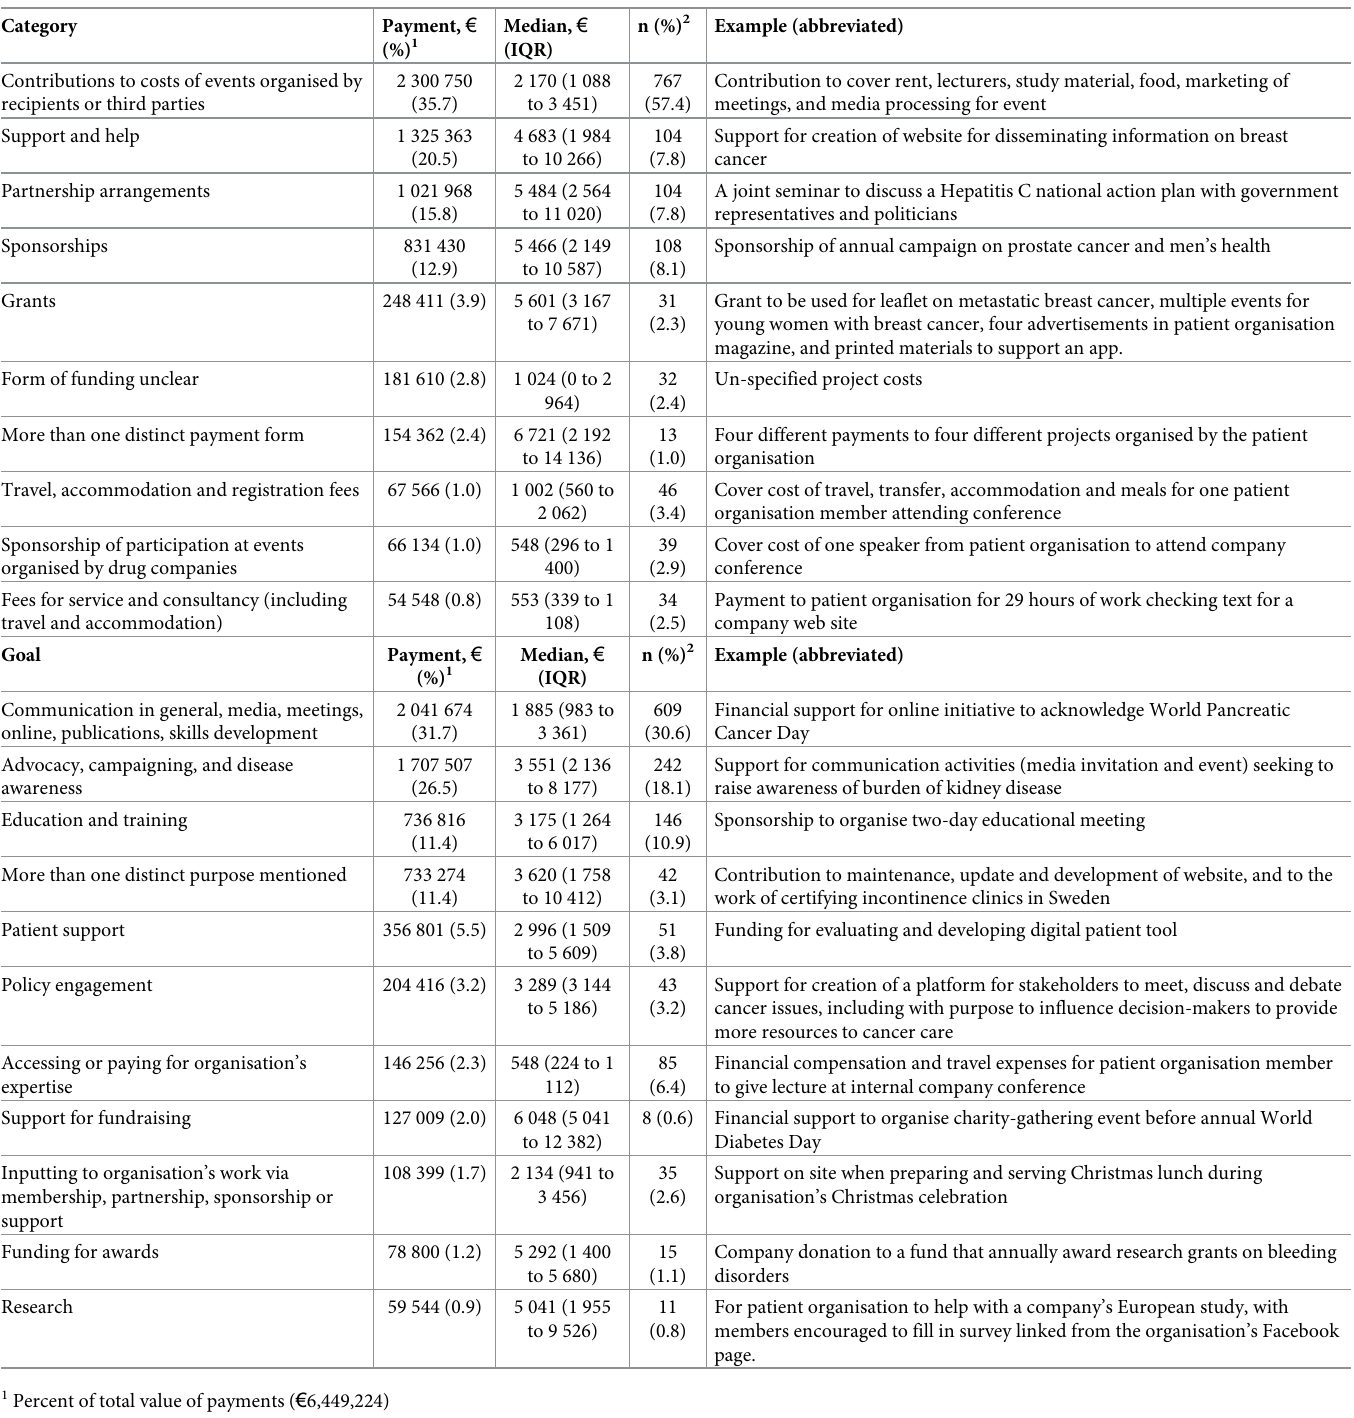
Table 4. Top 10 payment categories and goals in Sweden